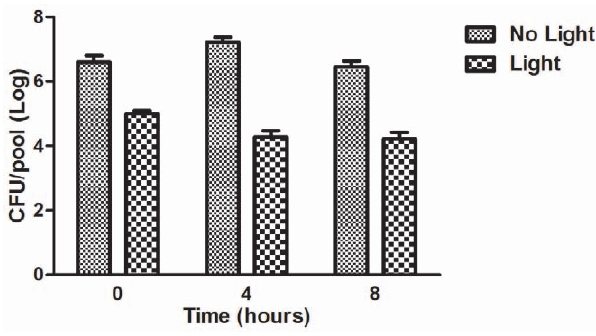
Figure 6. Number of bacterial cells in G.mellonella hemolymph over time post antimicrobial PDT treatment. Larvae were infected with 4.8 6 10 7 CFU/larva of E. faecium 007 and were maintained at 37 u C. After 90 min post-infection, the PS was injected. We waited additional 30 min prior to light irradiation. After light irradiation, the number of bacterial cells was quantified from pools of five larvae hemolymph per time point (0, 4 and 8 h after PDT that corresponded to 2, 6 and 10 h after infection). All PDT exposed groups resulted in significantly bacterial burden reduction when compared to the control group that was not exposed to PDT of each studied time-point (Student t test considering statistical significance with P , 0.05: immediately P =0.0080, 4 h P =0.0001, 8 h P =0.0010). Bars and Error bars represent respectively the mean and standard deviation of three pools per time point.